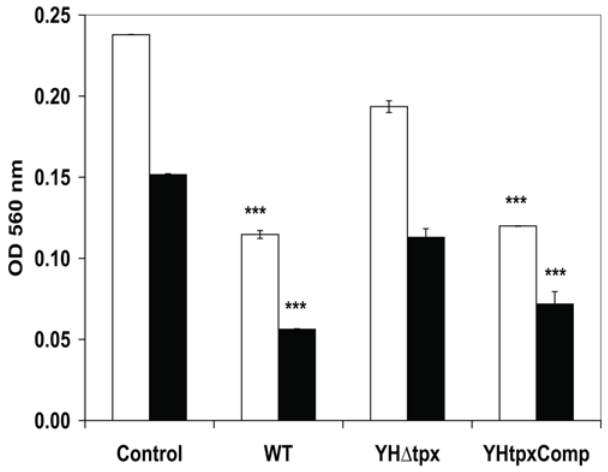
Figure 6. Biochemical analyses of peroxidase activities in M. tuberculosis WT, tpx mutant and the complemented strain. Presence of hydrogen peroxide was measured by xylenol orange assay. The open bar, initial H 2 O 2 at 1 mM. The solid bar, initial H 2 O 2 at 0.5 mM. Control, H 2 O 2 only. The data was repeated twice with similar results.